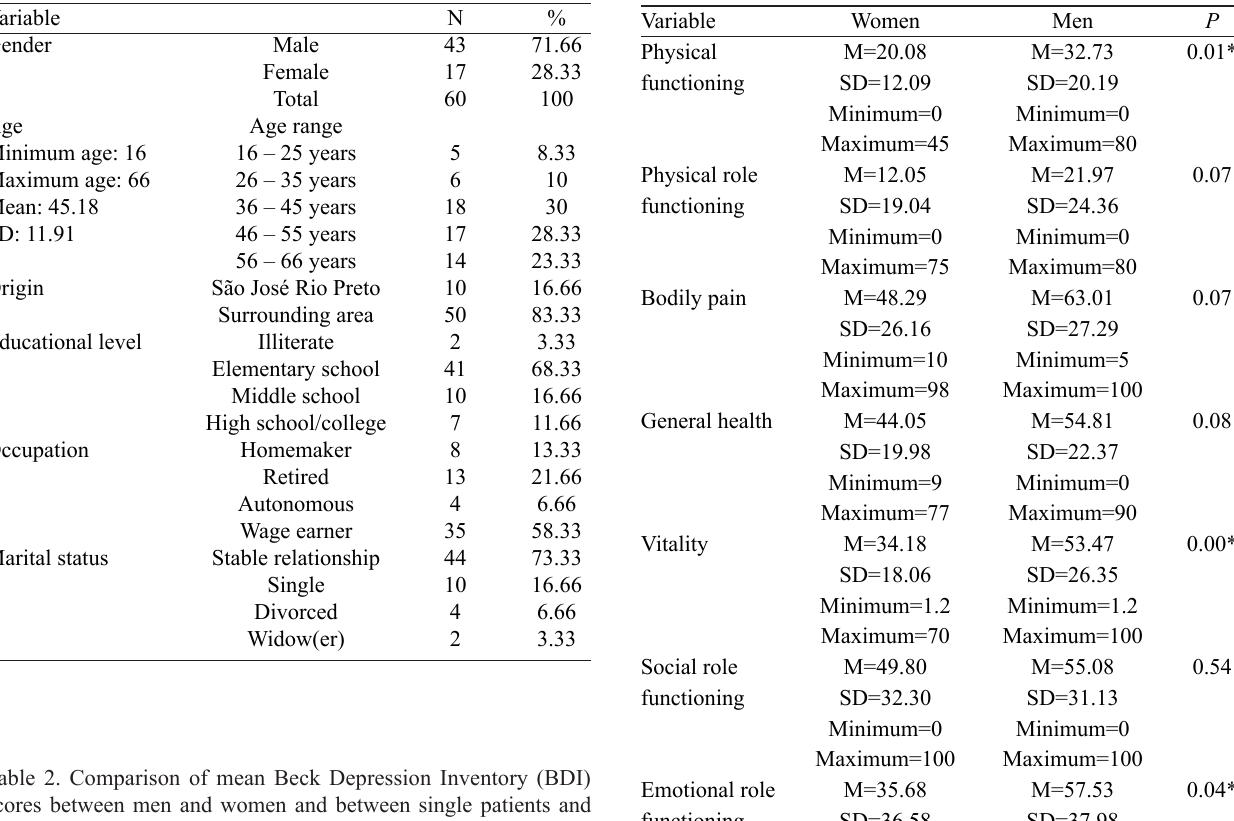
Table 1. Patients who underwent pre- cardiac transplantation psychological evaluation at the Base Hospital between 2004 and 2012.